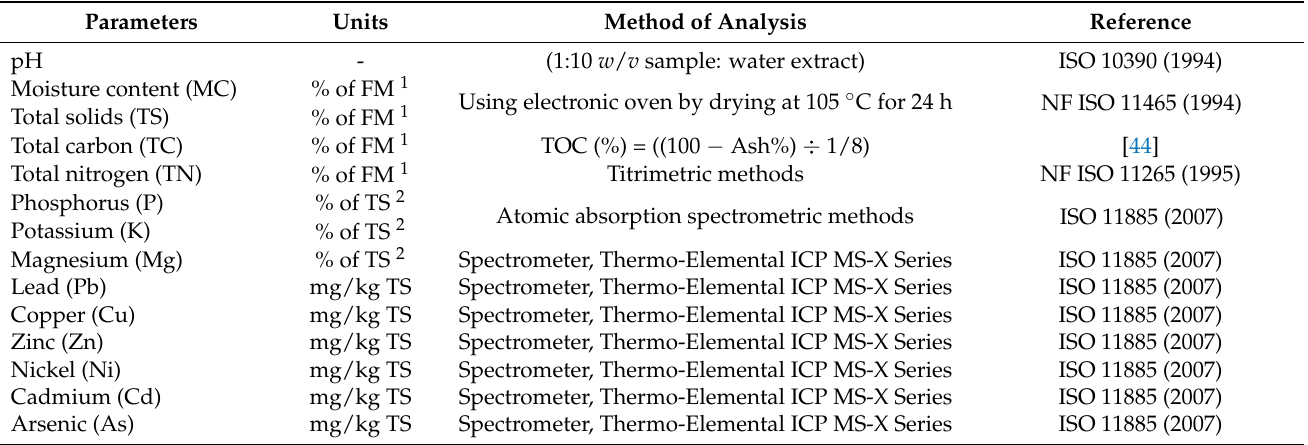
Table 2. Physical and chemical parameter measurement of biowastes chosen for biological treatment. Parameters Units Method of Analysis